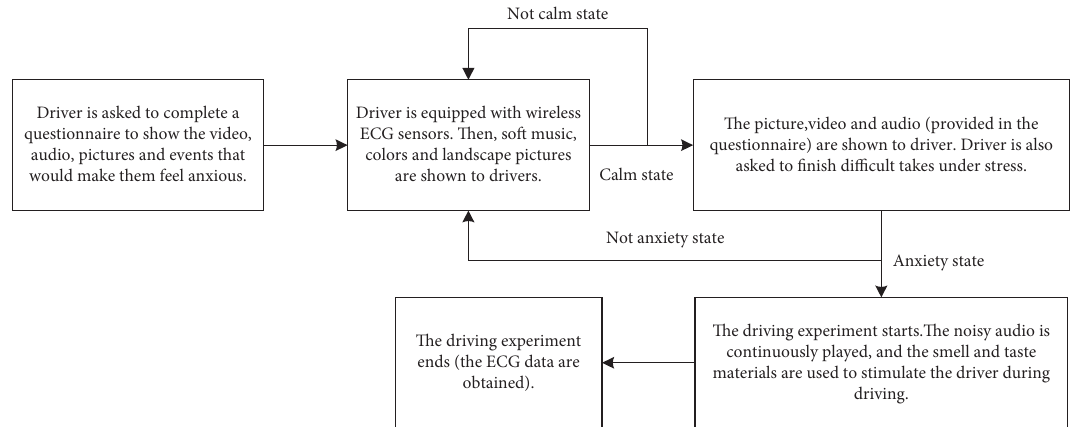
Figure 8: The experimental process of real driving in